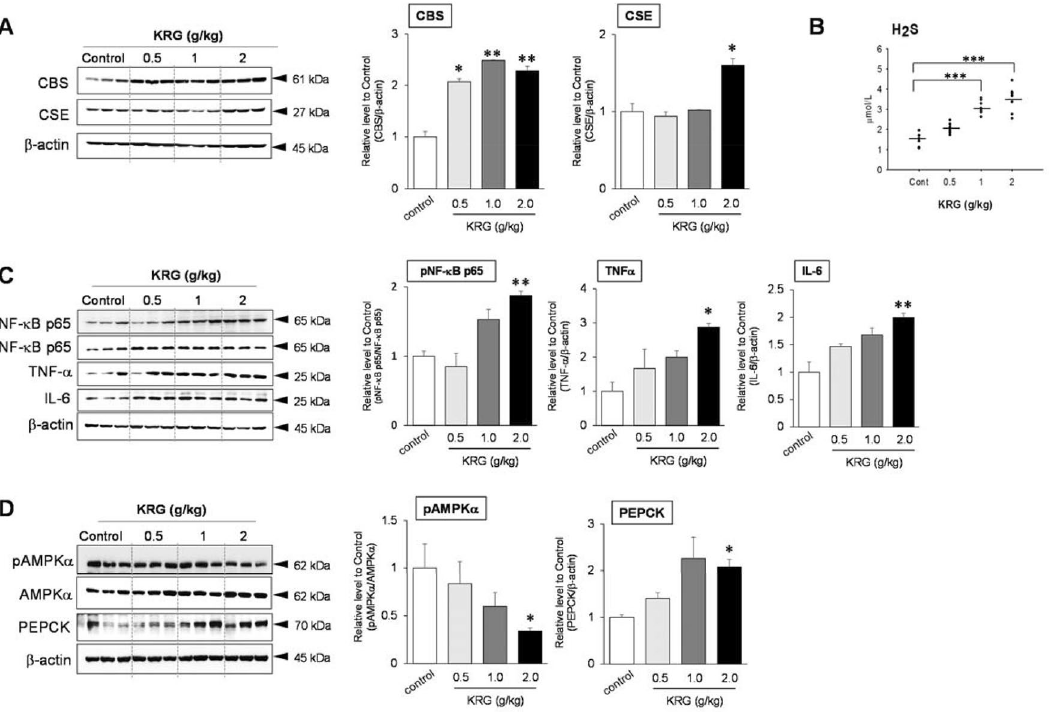
Figure 3. Verification of the changes in protein level in mouse liver following the administration of high- dose concentrations of KRG. Cystathionine β-synthase (CBS) and cystathionine γ-lyase (CSE) protein levels compared to β-actin via Western blots ( A ). H 2 S production based on ELISA ( B ). Changes in protein levels with increased H 2 S and the effects on liver injury ( C ) and the gluconeogenesis pathway ( D ) in mouse liver following the administration of high-dose concentrations of KRG. Bands were quantified using a densitometer in the ImageJ program, and the H 2 S results are expressed as mean ± SE ( n = 5–6). Statistical significance was set at * p < 0.05, ** p < 0.01, and *** p < 0.001 compared with the control based on an ANOVA (SPSS Statistics 23